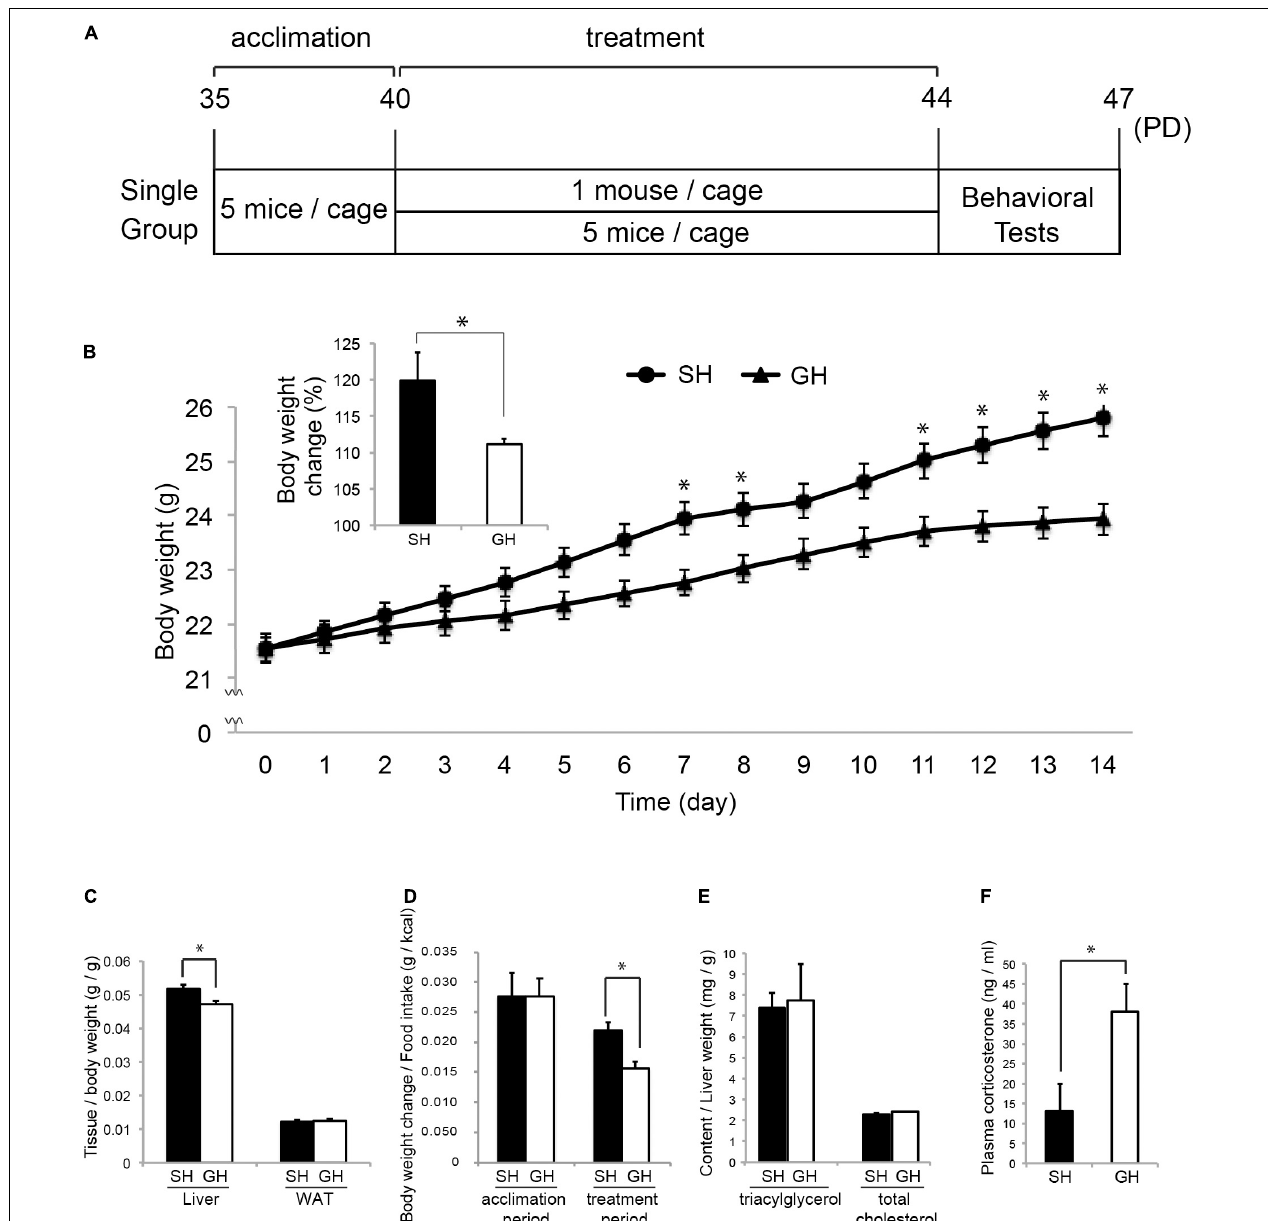
FIGURE 1 | Mouse housing and effect on the physical parameters. (A) Five-week-old (PD35) male C57BL/6N mice were acclimated for 5 days in group housing (GH) condition and maintained in single (SH) or GH conditions for 14 days. They were kept in the same open air rack to equalize all physical conditions other than social interaction and handled separately to reduce physical interaction between individuals ( Materials and Methods ). On the next day, the mice were subjected to the behavioral test in the following order: open-field test, Y-maze test, novel object recognition test, and social interaction test. Mice designated for tissue sampling were not tested. (B) Body weight (BW) change during the experimental period (from PD40 to PD44) with the inset of percentage BW change ( n = 35 for each group). (C) Relative weight of the liver and epididymal white adipose tissue (WAT) at the time of sacrifice, PD44 ( n = 25 for SH and GH). (D) Assimilation quotient of each group calculated as the ratio of the BW increase to the food intake (kcal) during the acclimation ( n = 15 for each group) or the experimental period ( n = 35 for each group). (E) Triacylglycerol (TG) and total-cholesterol (TCHO) content of the liver ( n = 4 for each group). (F) Comparison of plasma corticosterone levels ( n = 10 for each group). Values are mean ± SEM. *Significant difference detected by unpaired t -test ( p <